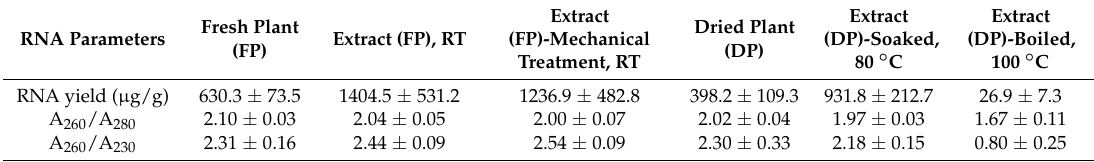
Table 1. Comparison of RNA isolated from mistletoe plants and lyophilized mistletoe extracts. Extract Fresh Plant RNA Parameters Extract (FP), RT (FP)-Mechanical (FP) Treatment, RT RNA yield ( µ